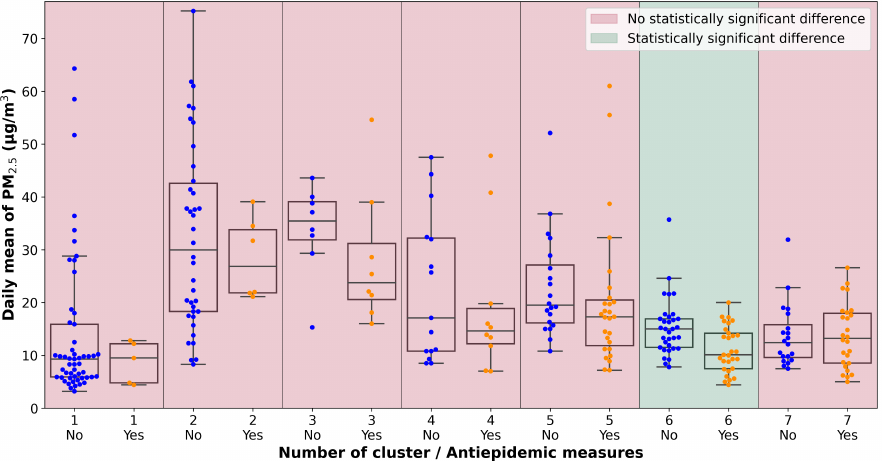
Figure 8. Results of the ANOVA test, Ostrava- ˇCeskobratrská, PM 2.5 .